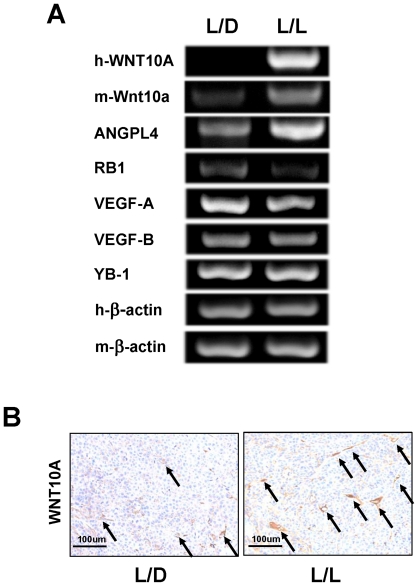
WNT10A was upregulated in L/L tumors.(A) RT-PCR of the relevant gene transcripts was carried out based on the results of the DNA microarray analysis. Human WNT10A (h-WNT10), mouse Wnt10a (m-Wnt10a) and ANGPL4 were upregulated in L/L mice tumors. RB1 was downregulated. There was no difference in the expression levels of VEGF-A, VEGF-B and YB-1 between L/L and L/D tumors. Human β-actin (h-β-actin) and mouse β-actin (m-β-actin) were used as internal control. The cycle number is 30 for all semi-quantitative RT-PCR except h-WNT10A. Nested PCR technique to investigate the expression of human WNT10A in tumors. The cycle number of 1st PCR is 30 and that of 2nd nested PCR is 35. (B) Immunohistochemical analysis of WNT10A in L/L and L/D mice tumors. The arrows indicate tumor blood vessels.